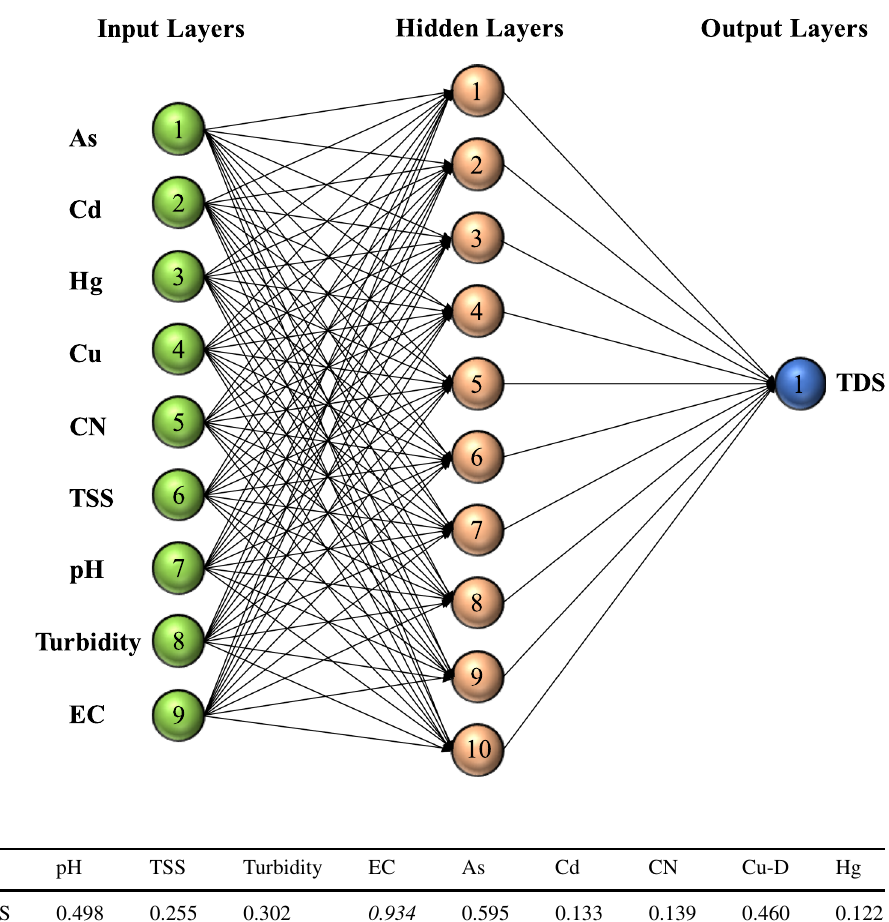
Fig. 2 Proposed structure of a